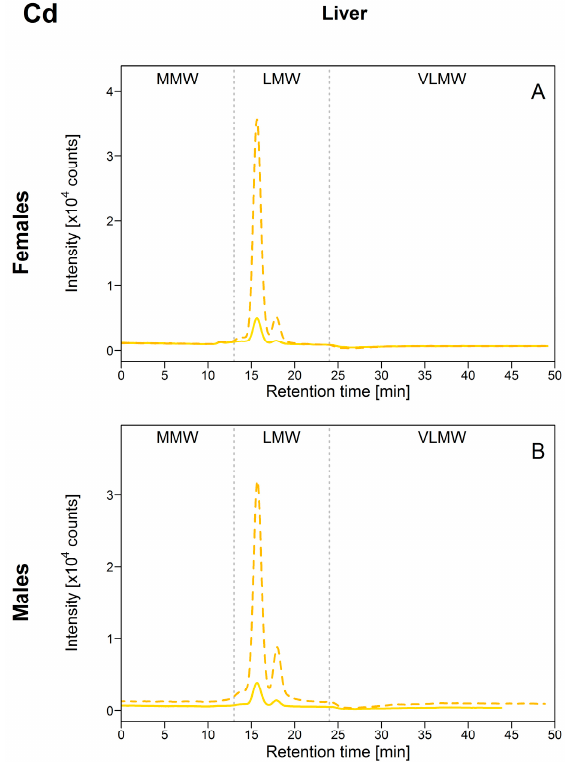
Figure 3. Size-exclusion chromatograms of Cd-binding biomolecules in hepatic HSP fractions of white suckers from a reference (full line) and metal-impacted lake (dotted line). Vertical dotted lines delimit the three operationally defined molecular weight biomolecule pools: MMW (0–13 min; >10 kDa), LMW (13–24 min; 10–2 kDa) and VLMW (>24 min; <2 kDa). ( A ) Female liver; ( B ) Male liver.